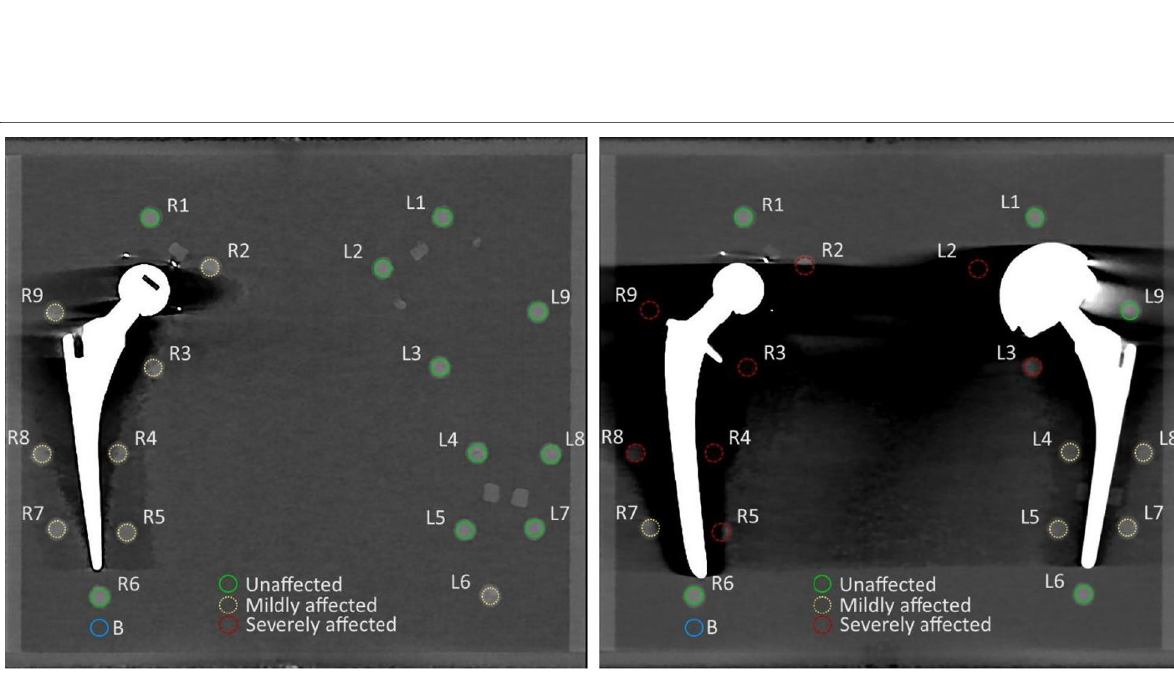
Fig. 4: 140 kVp conventional images without O-MAR with a unilateral prosthesis (left) and bilateral prostheses (right). Pellets were categorized as unaffected (green), mildly affected (yellow) and severely affected (red) pellets. The background region of interest (blue) was used to calculate contrast-to-noise